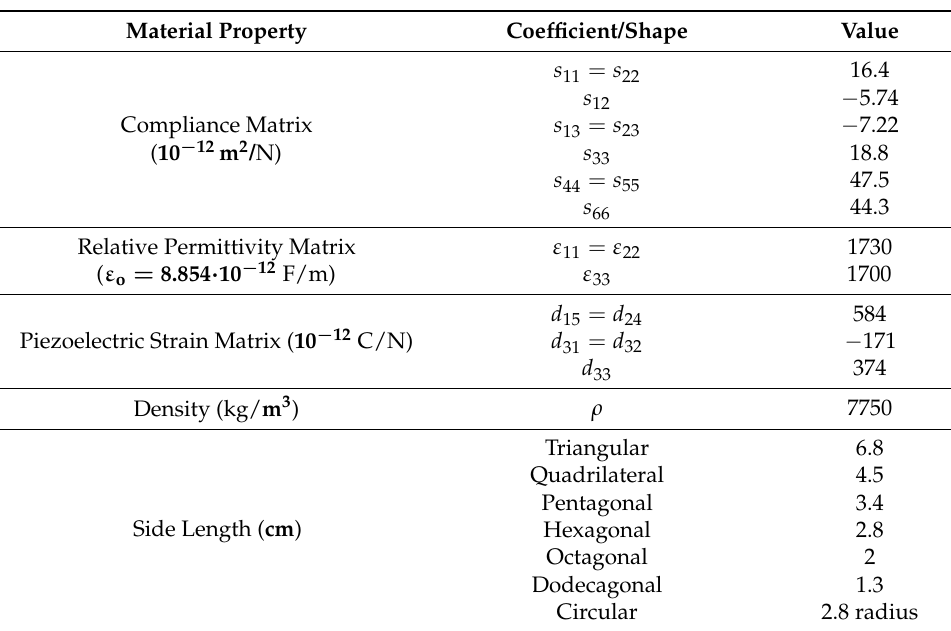
Figure 3. Shapes and location of the piezoelectric patches on the plate. Figure 3. shapes and location of the piezoelectric patches on the plate. Table 3. Material properties and dimensions of the piezoelectric models. Table 3. Material properties and dimensions of the piezoelectric